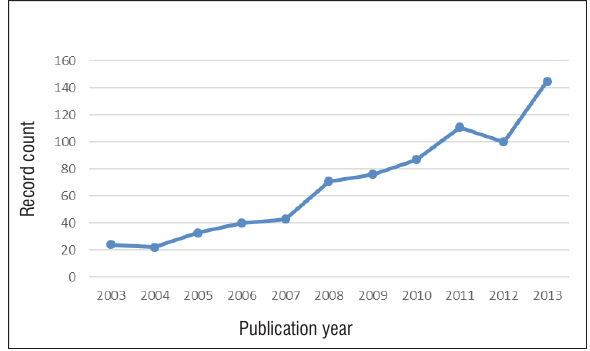
Figure 1: The number of Energy and Fuels articles from South Africa in the period 2003–2013.